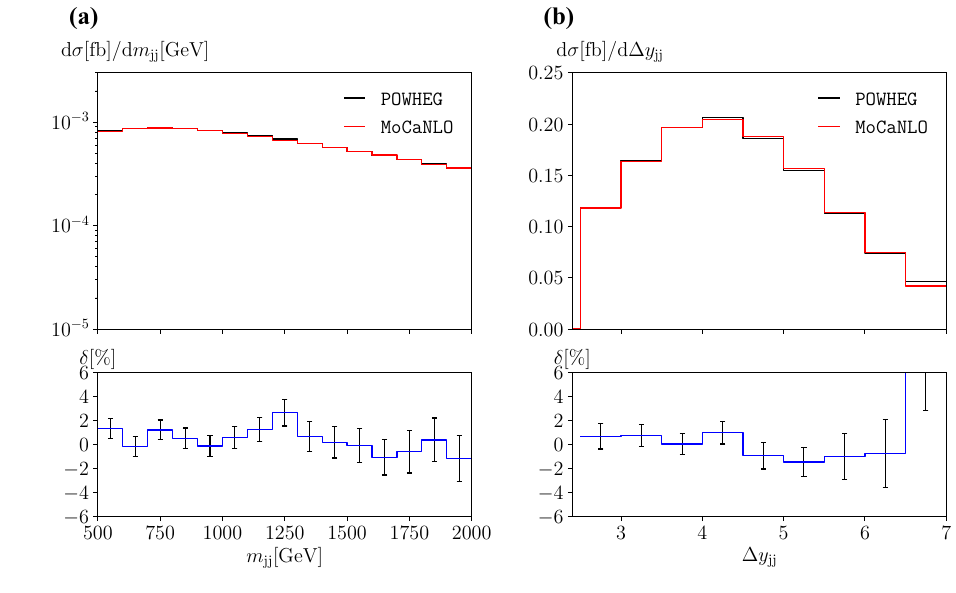
Fig. 3 Comparison of differential distributions between Powheg+Recola (this work) and MoCaNLO+Recola (Ref. [7]) at NLO EW [order (cid:2) (cid:3) α 7 O ] at a centre-of-mass √ s = 13TeV at the energy LHC for pp → μ + ν μ e + ν e jj: a invariant mass of the two leading jets (left), and b rapidity difference of the two leading jets (right). The upper panels show the two NLO predictions. The lower panels display the relative difference between the two computations with the corresponding statistical error bars dominated by the Powheg+Recola